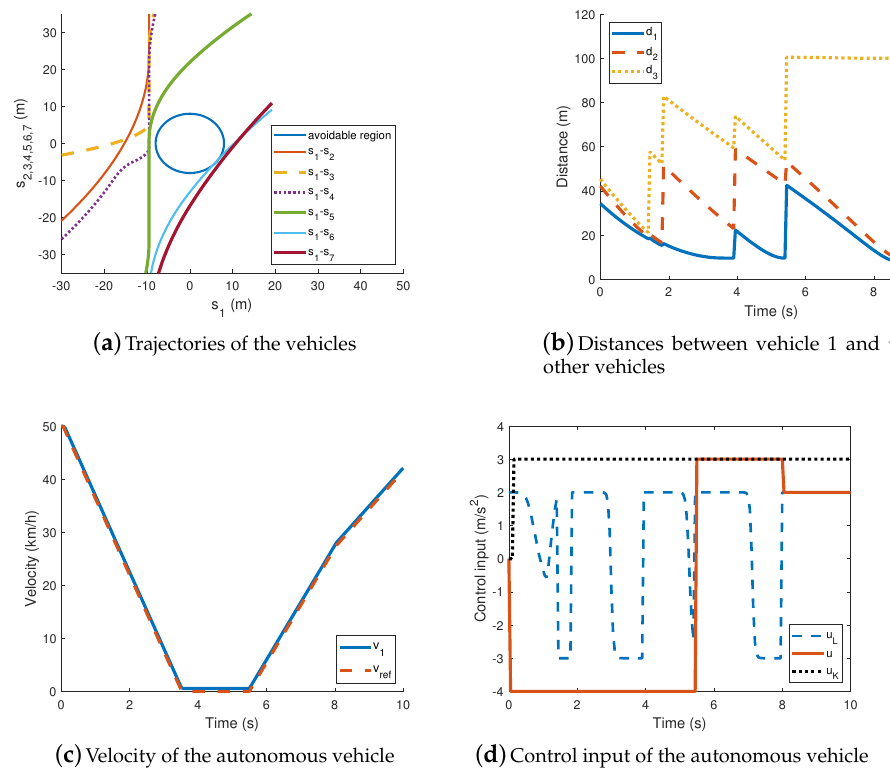
Figure 11. Signals of the complex fourth